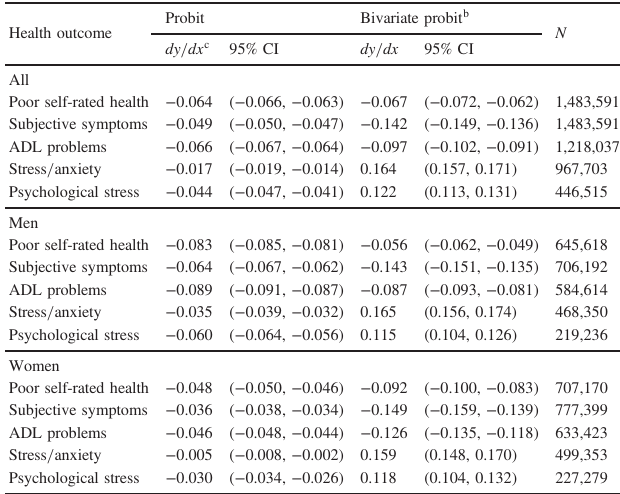
Table 4. Estimated associations of work with selected